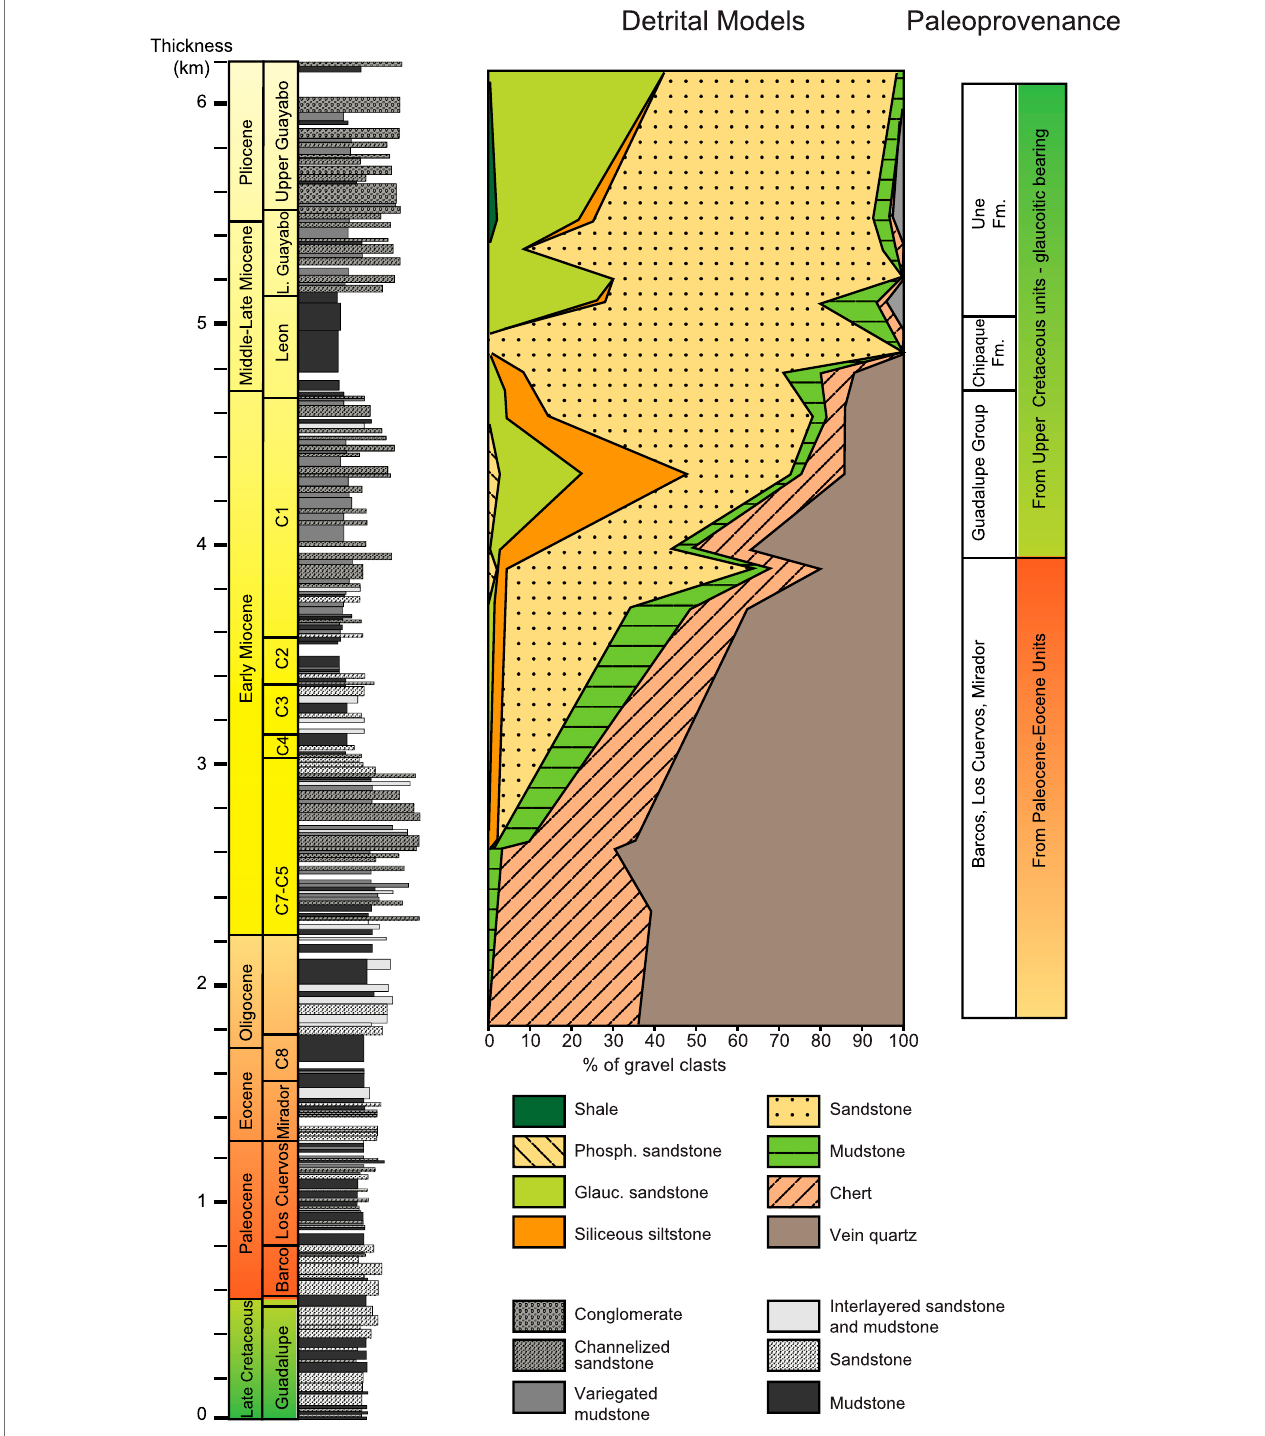
FIGURE 7 | Gravel-clast petrography analysis of the Medina Basin (modi fi ed from Parra et al., 2010).